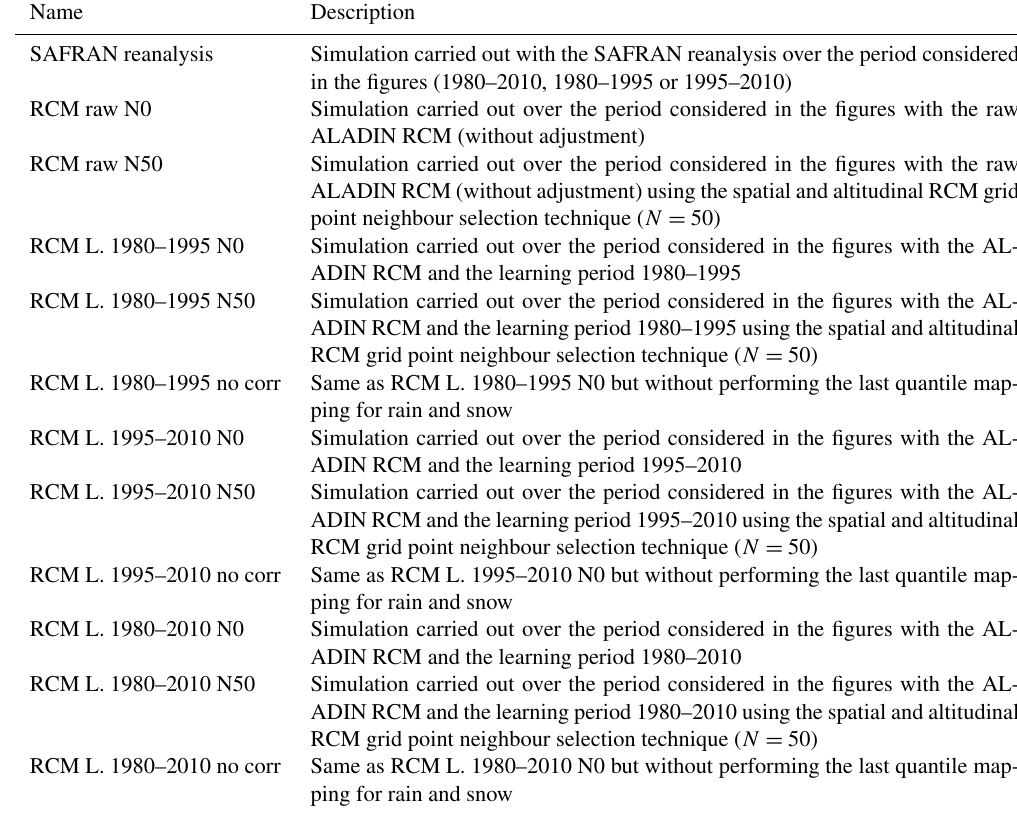
Table 2. Name and description of the different configurations used in the evaluation of the ADAMONT